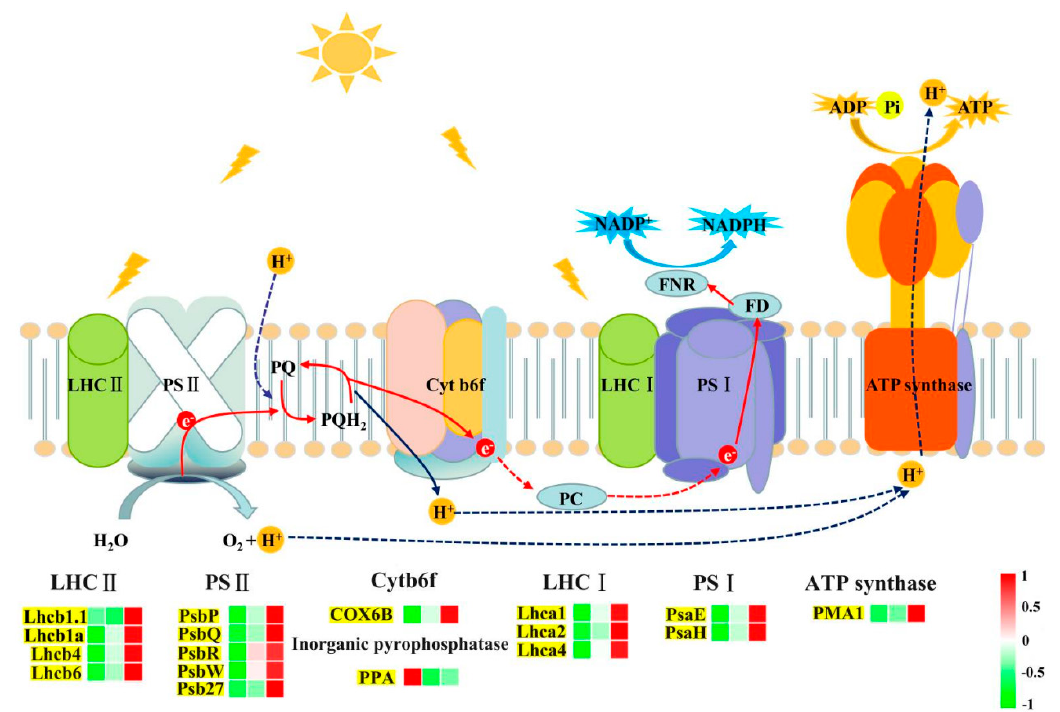
Figure 4. Expression patterns of photosynthetically related genes under low nitrogen and high nitrogen. The three squares under the gene names indicate expression abundance of low N, control N, and high N. Image of photosynthetic electron transport originated from Plant Physiology , 5th edition [27].